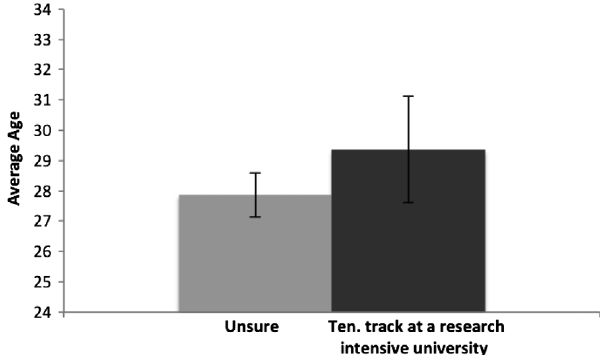
FIG. 6. Percentage of PER graduate students reporting being unsure about where they want to and where they expect to be working in ten years (values are the percentage of the subgroup populations).